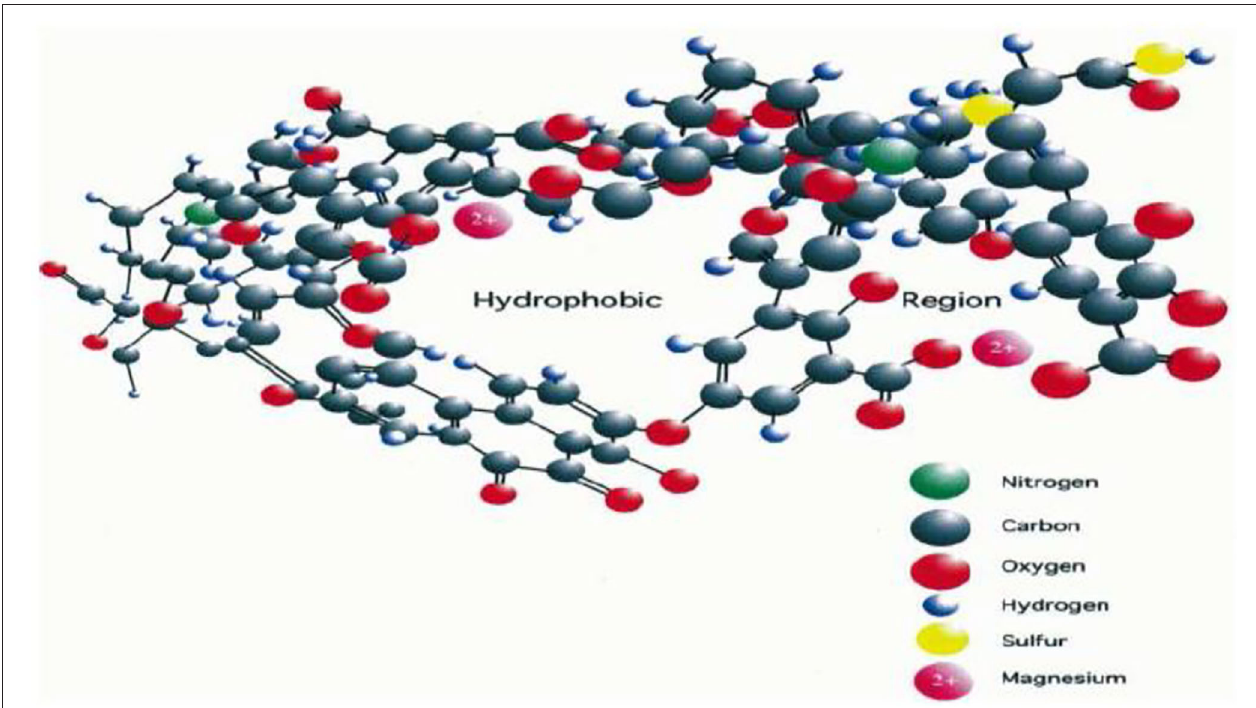
FIGURE 8 | Portion of the “pseudomicelle type” structure of humic acids. (Salati et al., 2011).